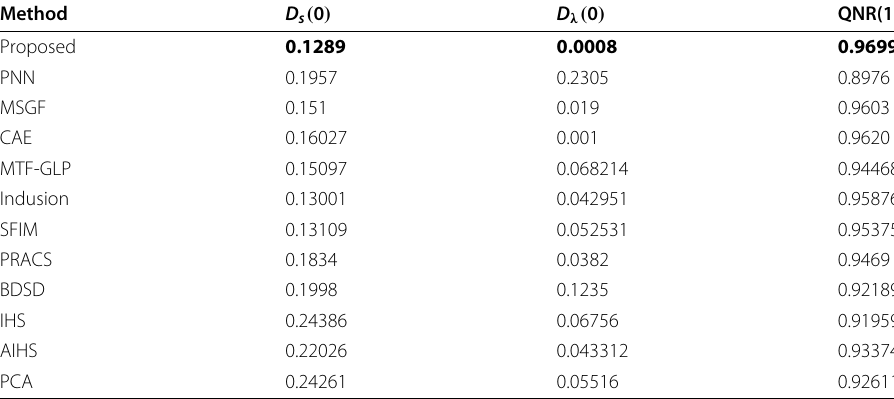
Table 5 Numerical results of the real QuickBird-1 dataset